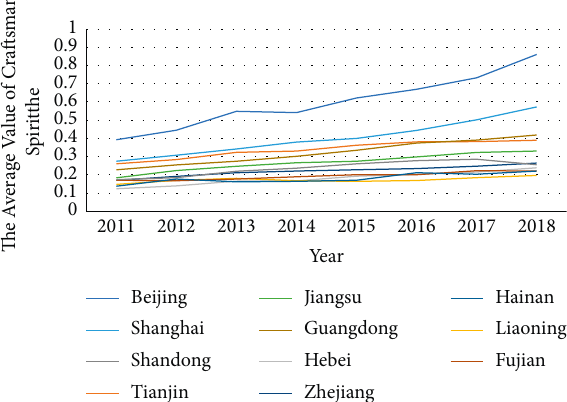
Figure 3: The trend of the average value of craftsman’s spirit in the construction industry in the eastern regions from 2011 to 2018.